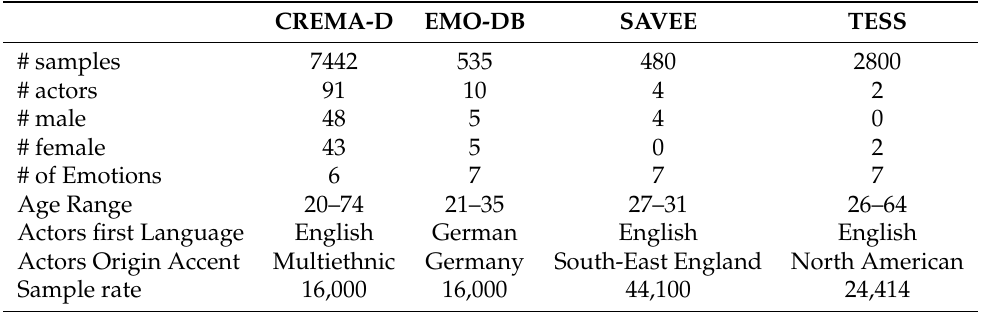
Table 4. Table containing basic information regarding datasets considered for training of the speaker emotion recognition